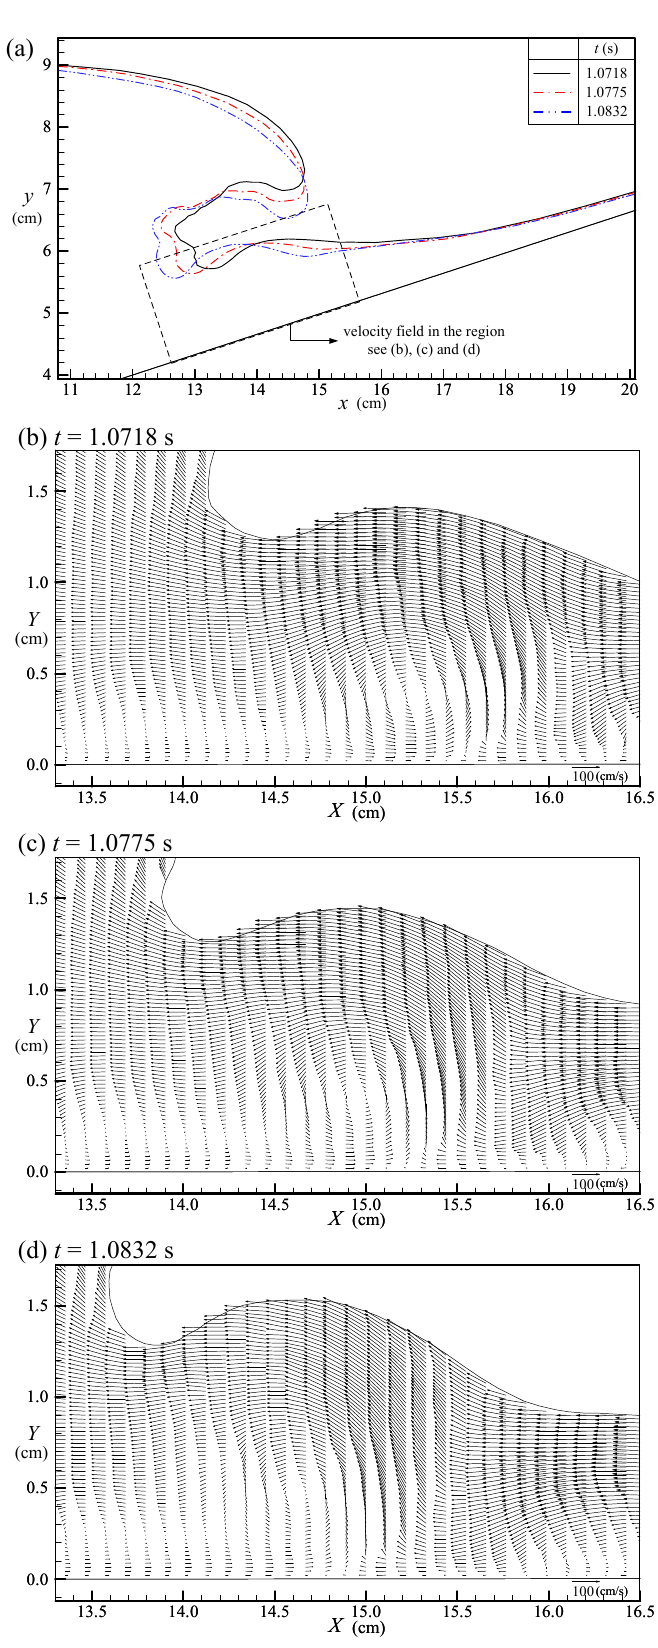
Figure 18. ( a ) The free surface profiles obtained at t = 1.0718, 1.0775 and 1.0832 s. The velocity fields in the vicinity of the primary vortex at t = ( b ) 1.0718 s; ( c ) 1.0775 s; and ( d ) 1.0832 s.